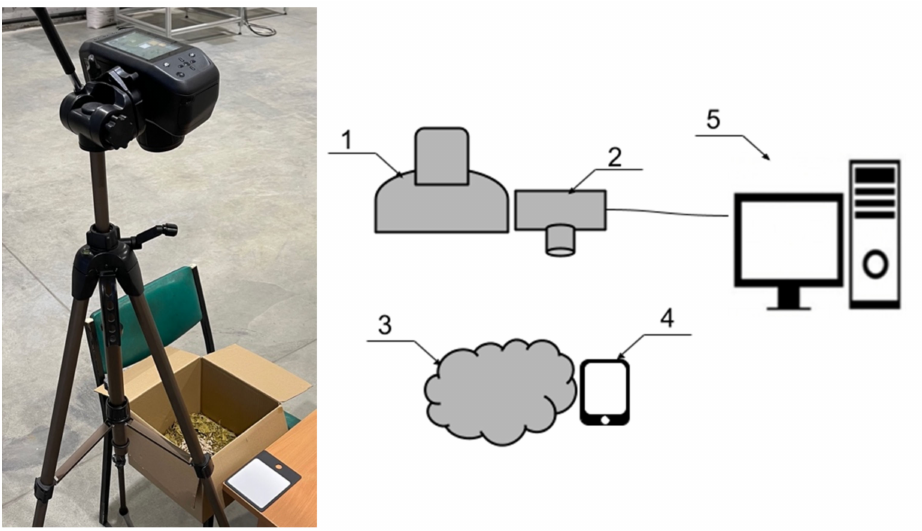
Figure 1. Photo taken during the experiment ( left ), functional diagram of the laboratory installa- tion ( right ): 1—illuminator, 2—hyperspectral camera, 3—sample under study, 4—calibration pad, 5—computer for image